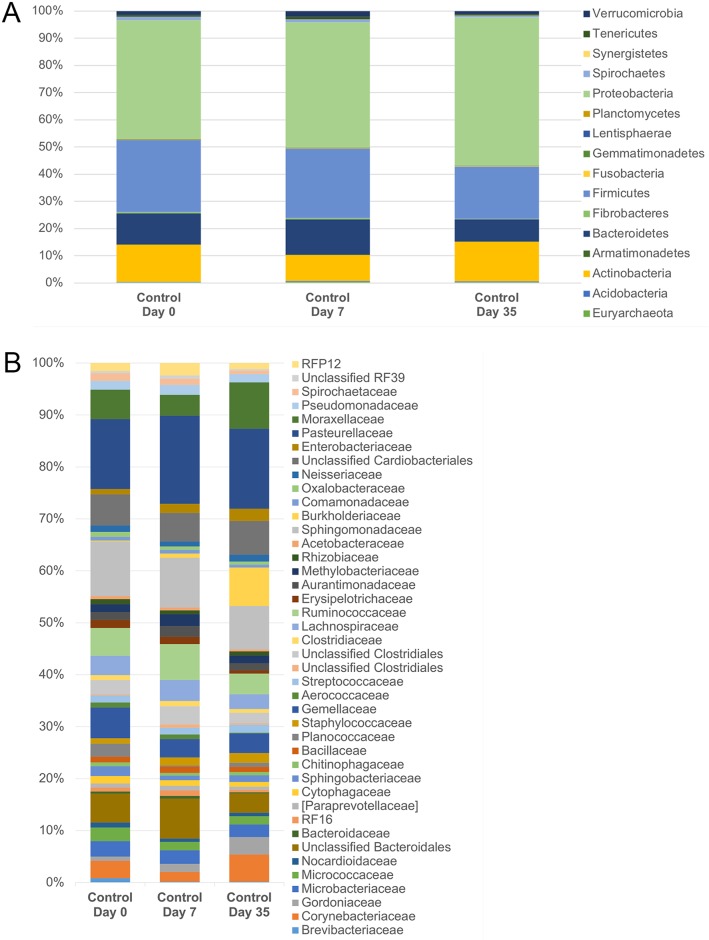
Temporal composition by bacterial phyla (A) and families (B) in control eyes.Data are presented at baseline (day 0), day 7, and day 35. The bars represent mean percentage of sequences, totaling 100% at each time point.